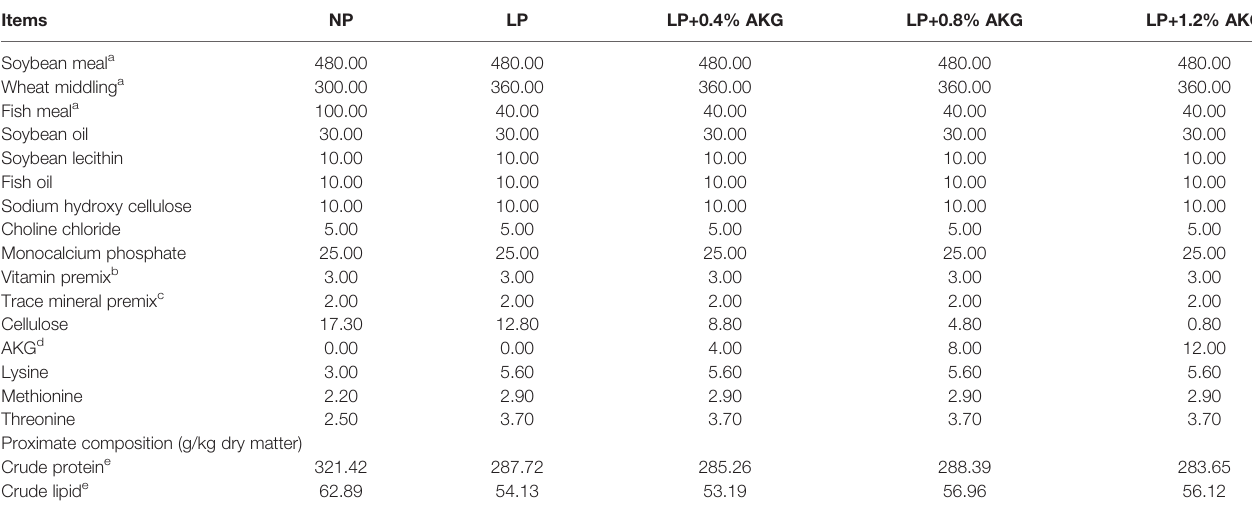
TABLE 1 | Composition and nutrients content of the experimental diets (g/kg, dry